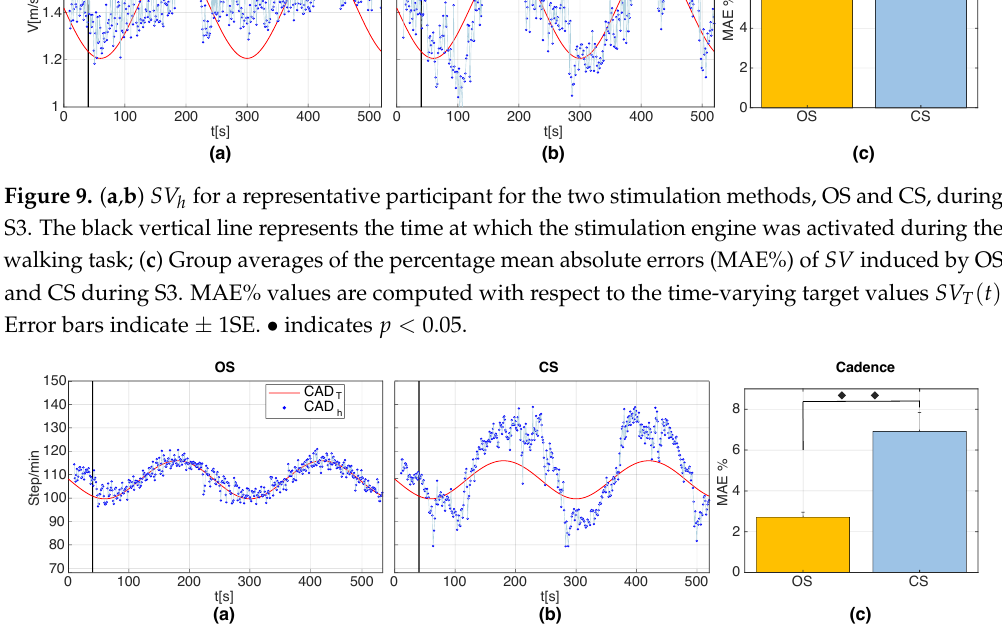
Figure 10. ( a , b ) CAD h for a representative participant for the two stimulation methods, OS and CS, during S3. The black vertical line represents the time at which the stimulation engine was activated; ( c ) Group averages of the percentage mean absolute errors (MAE%) of CAD induced by OS and CS during S3. MAE% values are computed with respect to the time-varying target values CAD T ( t ) . Error bars indicate ± 1SE. • • indicates p <